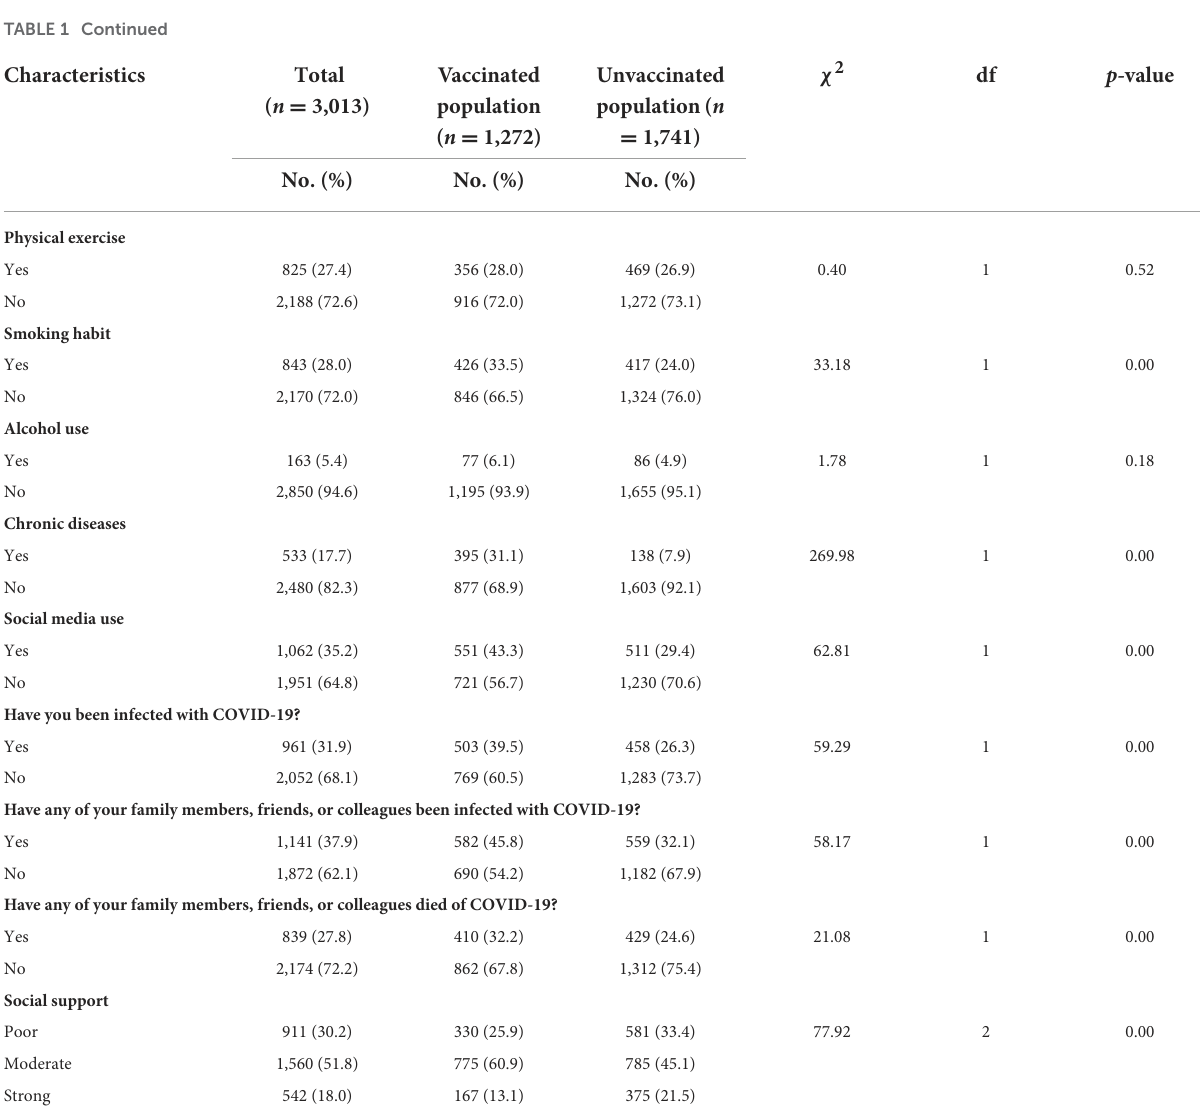
Spearman’s correlations of psychological effects among vaccinated and unvaccinated populations are shown in Table